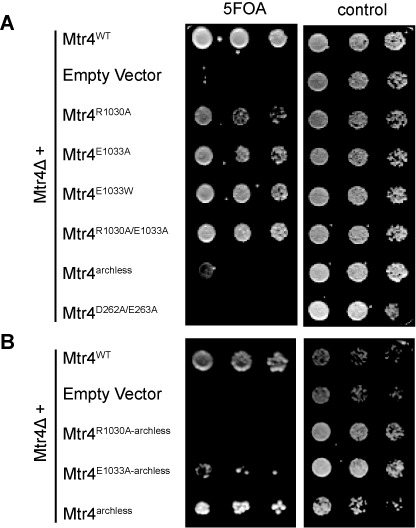
Growth complementation of an Mtr4-knockout strain by ratchet helix mutants. (A) Slow growth phenotypes are observed for each of the Mtr4 ratchet helix mutants. The indicated plasmids were introduced into a yeast strain that had the Mtr4WT gene deleted from the chromosome, and that also contained a plasmid encoding Mtr4WT with an URA3 selectable marker. Growth on 5-FOA plates selects for cells that have lost the URA3 plasmid, and thus shows a slow growth phenotype associated with each mutant. Mtr4archless has a more severe slow growth phenotype than any of the ratchet helix mutants. Mtr4D262A/E263A removes residues required for the binding and hydrolysis of ATP and is used as a negative control. (B) Double mutants of ratchet helix point mutations combined with an arch deletion. No growth is observed for the Mtr4R1030A-archless mutant and slow growth is observed for the Mtr4E1033A-archless mutant.